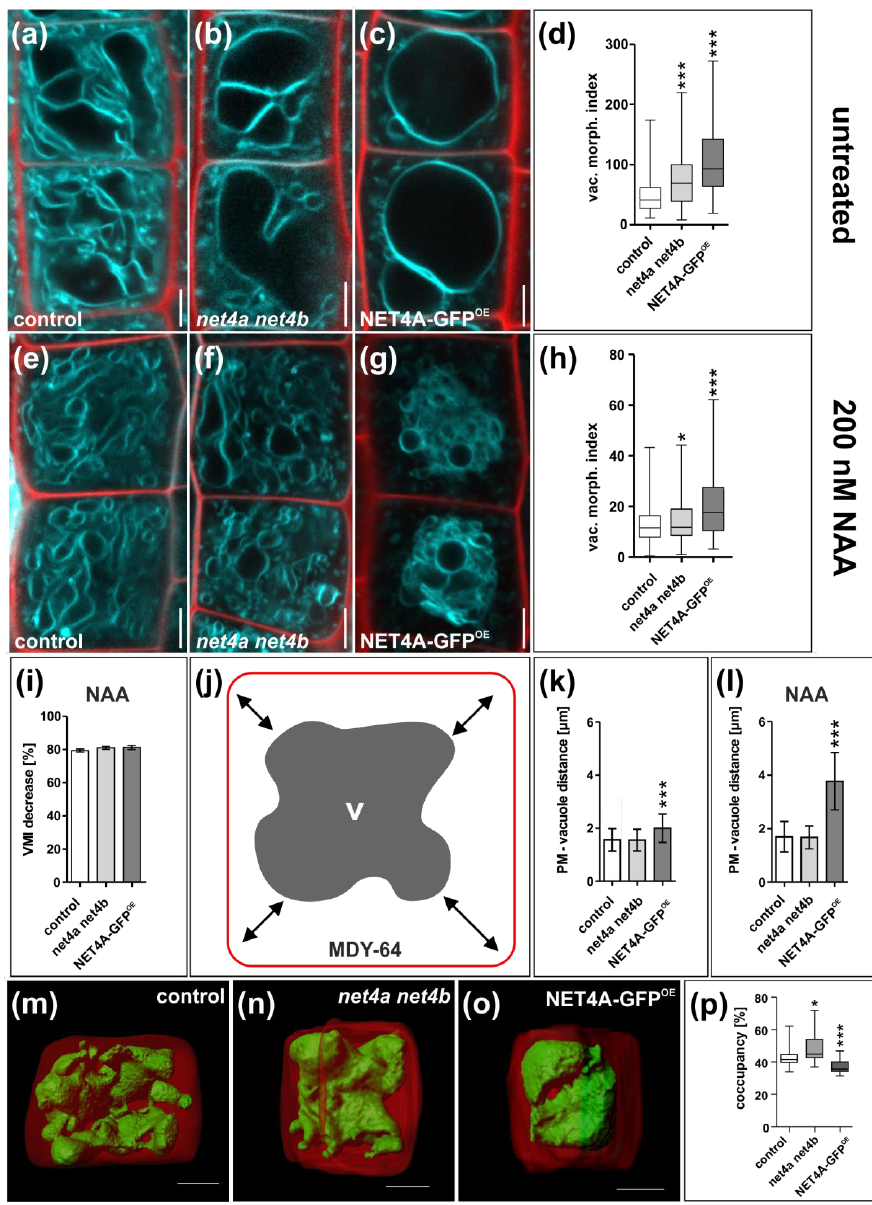
Figure 3. NET4 abundance impacts on vacuolar morphology, modulating compactness. ( a – d ) Vacuolar morphology in the late root meristem of the net4a net4b double knockout line ( n = 145) and of the NET4A-GFP line driven by the 35S promoter (NET4A-GFP OE ; n = 99) in comparison to the Col-0 control ( n = 334). ( e – h ) Vacuolar morphology upon auxin treatment (200 nM NAA) in the control ( n = 147), net4a ne4b ( n = 153) and NET4A-GFP OE ( n = 88) line. ( i ) Relative VMI decrease. ( j ) Vacuolar compactness was assessed by measuring plasma membrane to vacuole distance based on MDY-64 staining. The distance was measured in every cell corner and the mean calculated. ( k ) Quantification of plasma membrane to vacuole distance in net4a net4b ( n = 72) and NET4A-GFP OE ( n = 22) in comparison to the Col-0 control ( n = 75). ( l ) Quantification of auxin-induced changes (200 mM, 20h) of plasma-membrane–vacuole distance in the control ( n = 59), net4a net4b ( n = 42) and NET4A-GFP OE ( n = 20). ( m – o ) Three-dimensional reconstructions of PI-stained cell wall (red) and BCECF-stained vacuole (green) of late meristematic cells from control ( n = 20), net4a net4b ( n = 19) and NET4A-GFP OE ( n = 22) lines. ( p ) Quantification of vacuolar occupancy of the cell. Columns of bar charts represent mean values, error bars represent s.e.m. Box limits of boxplots represent 25th percentile and 75th percentile, horizontal line represents median. Whiskers display minimum to maximum values. Student’s t -test, p -values: * p < 0.05; *** p < 0.001. Scale bars: 5 µ